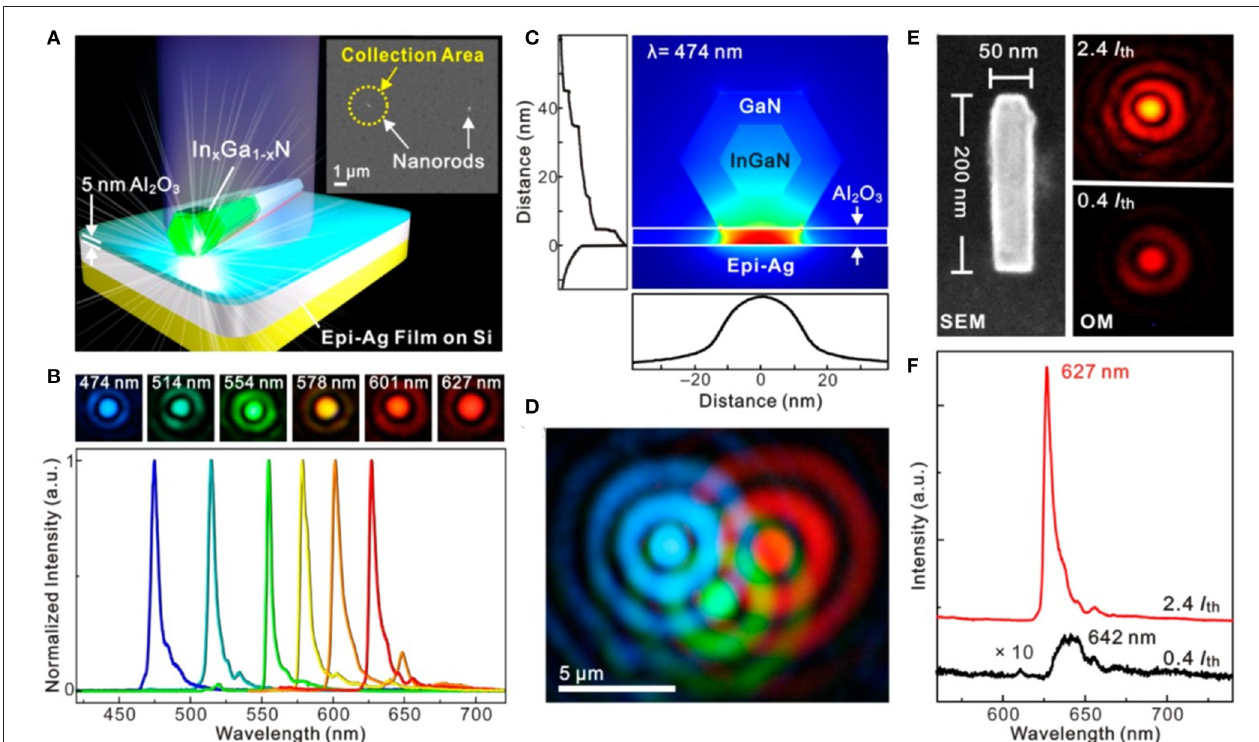
FIGURE 8 | (A) Schematic of the plasmonic nanolaser. Inset shows the SEM image of the structure. Scale bar: 1 µ m. (B) All-color, single-mode lasing emissions with HWFM ∼ 4nm from single nanorods. (C) Simulated mode field distribution of the nanolaser at wavelength of 474nm. (D) Concurrent RGB lasing from three nanorods placed close to each other. Scale bar: 5 µ m. (E) left panel: SEM image of the device. Optical microscope image below (0.4 I th , upper right panel) and above (2.4 I th , lower right panel) lasing threshold. (F) Spectra of the nanolaser. Red line: spontaneous emission (642nm). Black line: lasing (627nm). (A–F) Reproduced with permission. Lu et al. (2014) Copyright 2014, American Chemical